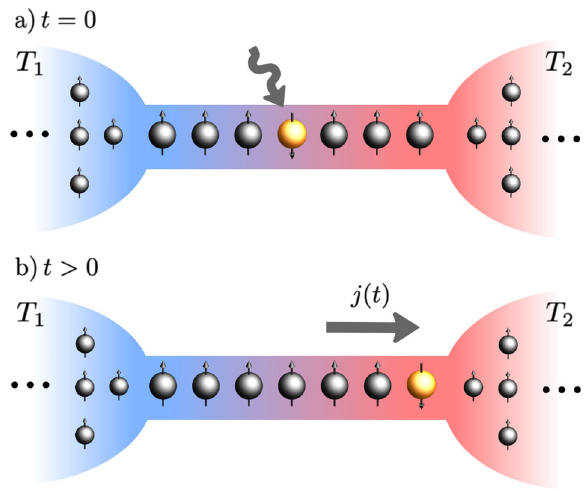
Fig. 1 Sketch of the system. A small link connects a hot (red, right) reservoir at temperature T 2 to a cold (blue, left) reservoir at T 1 ( T 2 > T 1 ). Initially, the system is completely polarized (black ‘ spin-up ’ particles), and by assumption there is a time-independent temperature gradient across the link. a At t = 0 a particle at the center of the system has its internal state changed by a spin- fl ip pulse. b Due to the presence of the temperature gradient, one observes a spin current across the system, which is caused by the motion of the impurity from the low- to the high-temperature